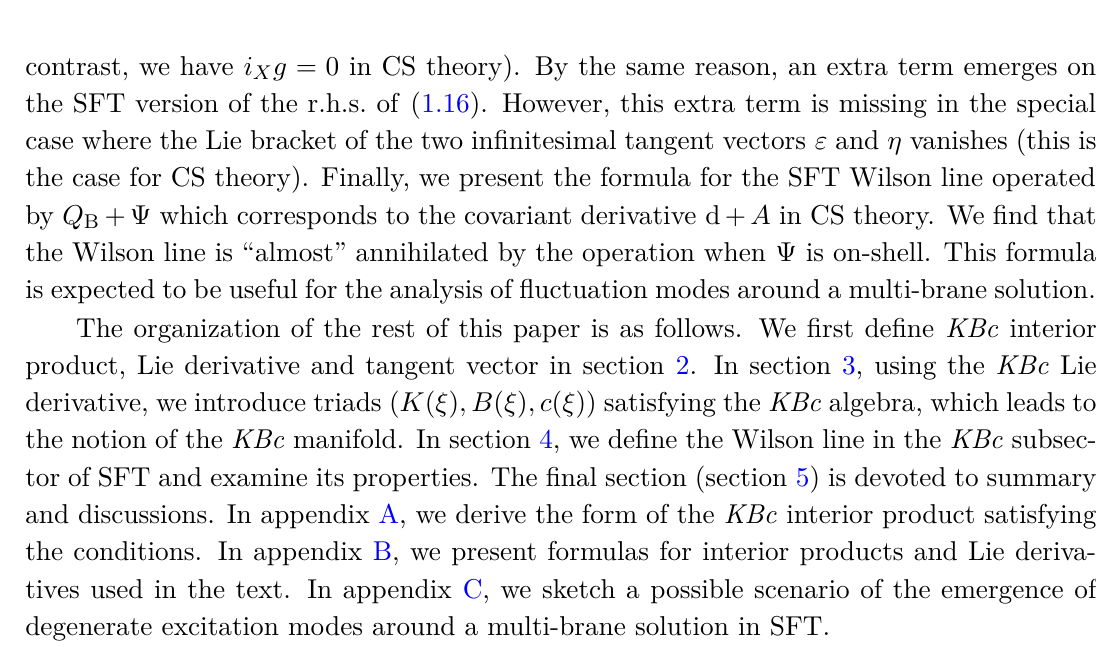
Figure 1 . The two paths C 1 and C 2 on M 3